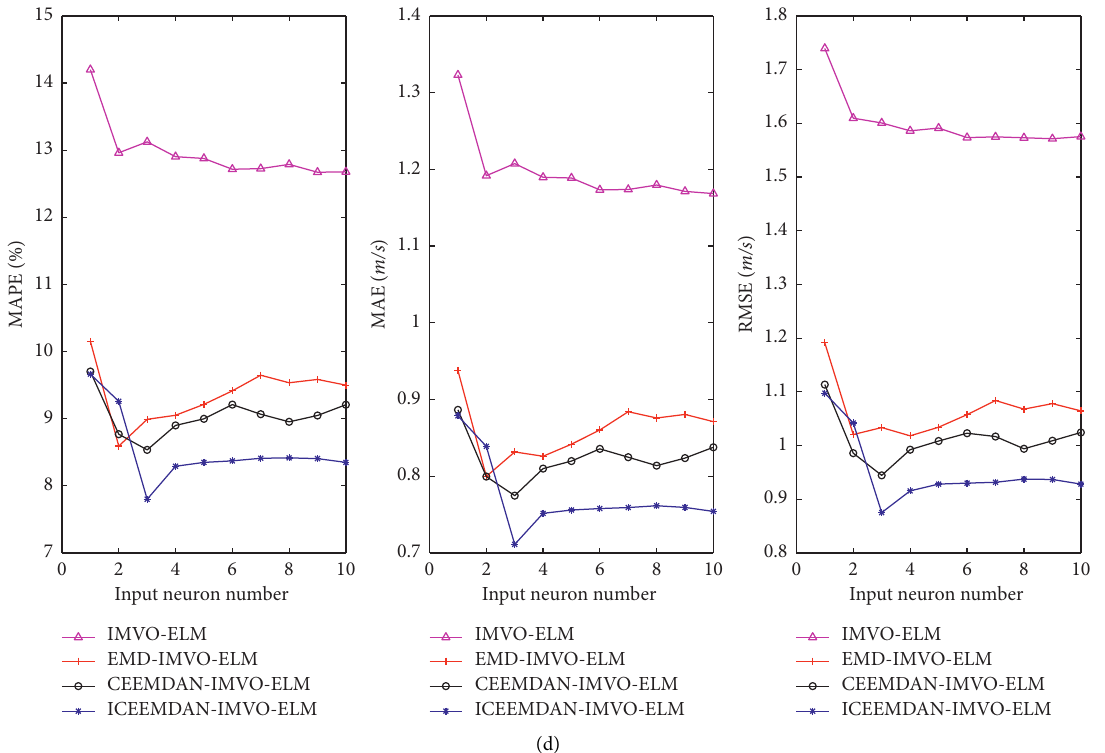
Figure 5: Traversing calculation of input neuron number of different prediction methods. (a) Dataset A. (b) Dataset B. (c) Dataset C. (d) Dataset D.